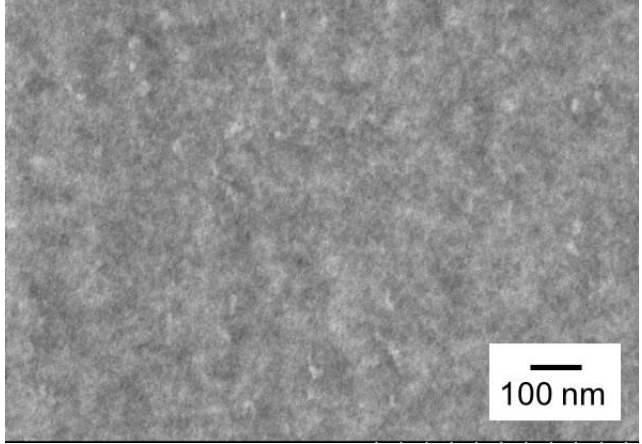
Figure 3. TEM image of PC/CPE (50/50).